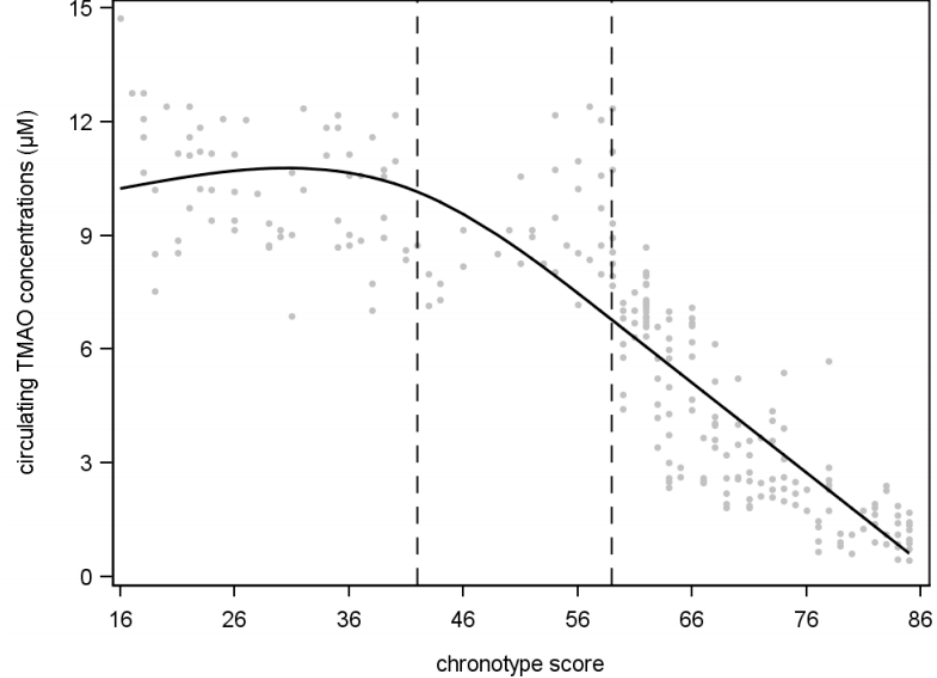
Figure 3. Association between circulating TMAO concentrations and chronotype score based on restricted cubic spline model in study population. A chronotype score ≥ 59 demonstrated a more significant inverse linear relationship with circulating TMAO concentrations compared with knots <59 (neither chronotype) and <41 (evening chronotype).